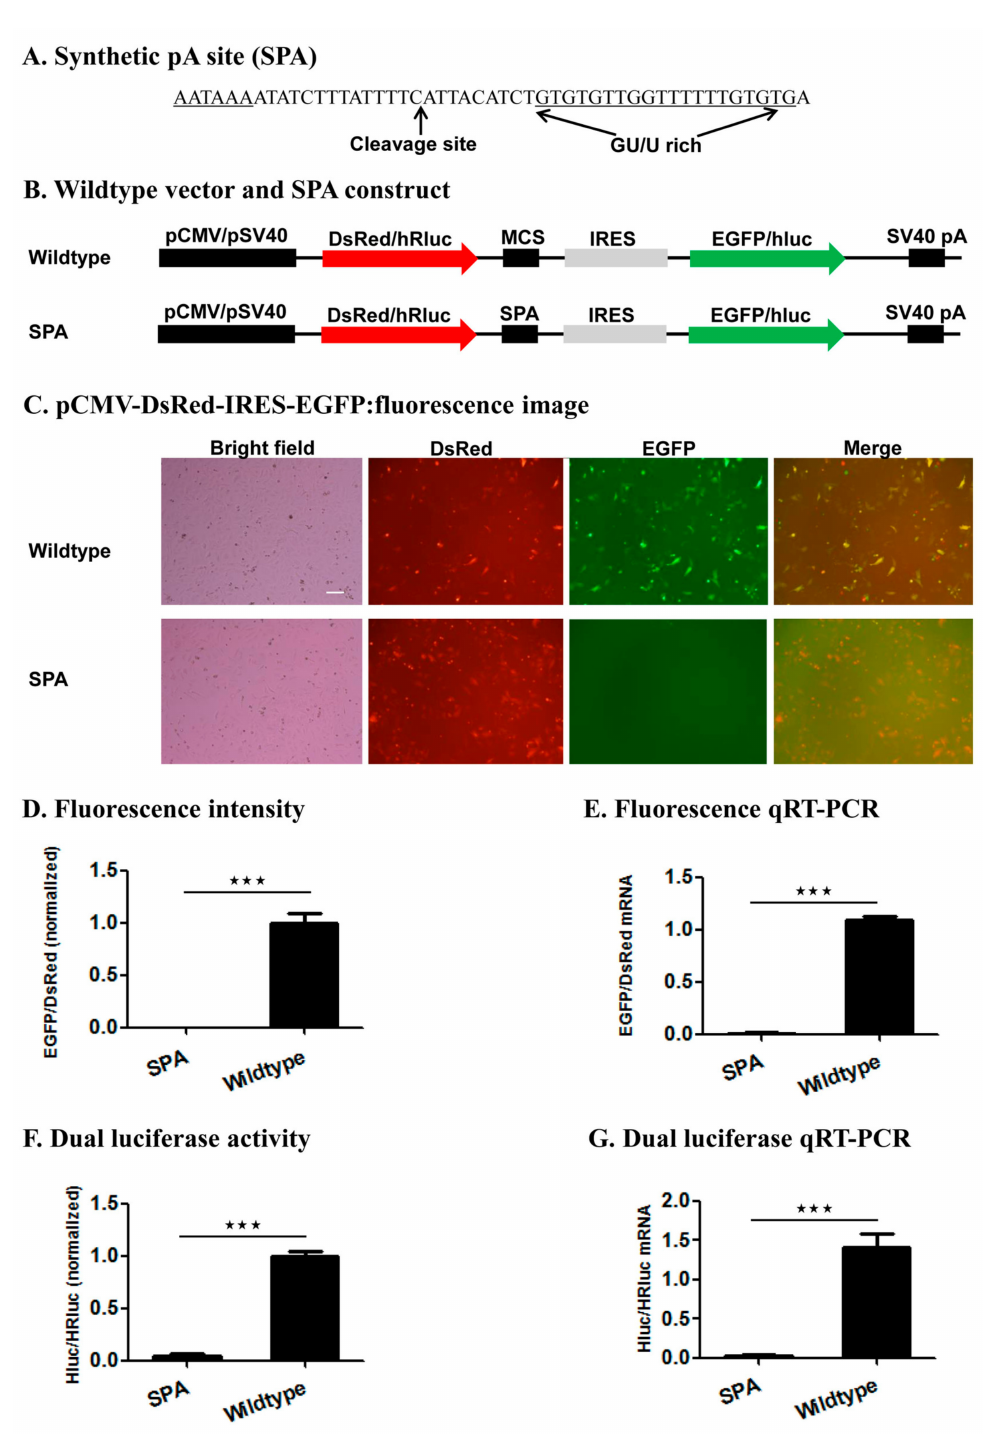
Figure 3. Impact of inserting a synthetic pA (SPA) site on the relative expression of the two luciferase or fluorescence reporter genes. ( A ) Synthetic pA site (SPA); ( B ) Wildtype vector and SPA construct; ( C ) pCMV-DsRed-IRES-EGFP: fluorescence image. Shown here is a representative Hela cell image of 3 independent transfections per construct with a scale bar of 20 µ m; ( D ) Fluorescence intensity; ( E ) Fluorescence qRT-PCR; ( F ) pSV40-hRluc-IRES-hluc: dual luciferase activity; ( G ) Dual luciferase qRT-PCR. The data and error bars in ( D – G ) represent the means and standard errors of at least three independent transfections (biological replicates) for each wildtype vector or SPA construct. Extremely significant differences between the wildtype vector and SPA construct are indicated by three stars (***, p <